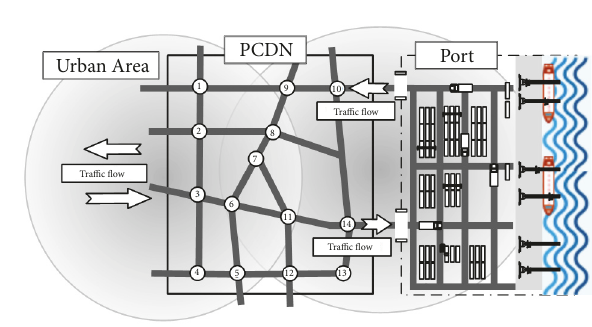
Figure 1: The relationship between PCDN, and ports and urban